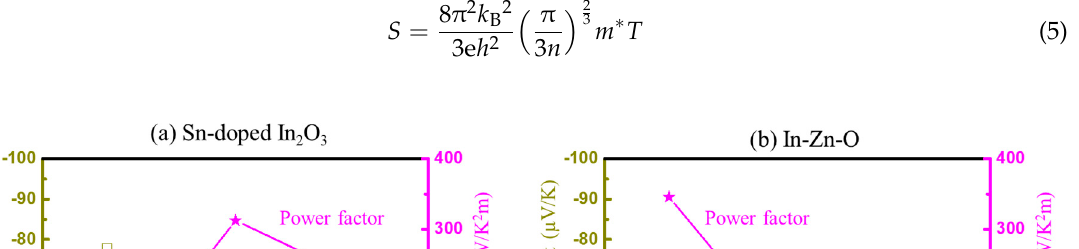
Table. 1. σ , S , κ , κ e , κ l , PF, and ZT values for the c ‐ ITO ( T S = 200 °C) and a ‐ IZO ( T S = RT) films. The a ‐ IZO fi lm shows twice higher ZT values compared to c − ITO due to low κ l that comes from amorphous structure.